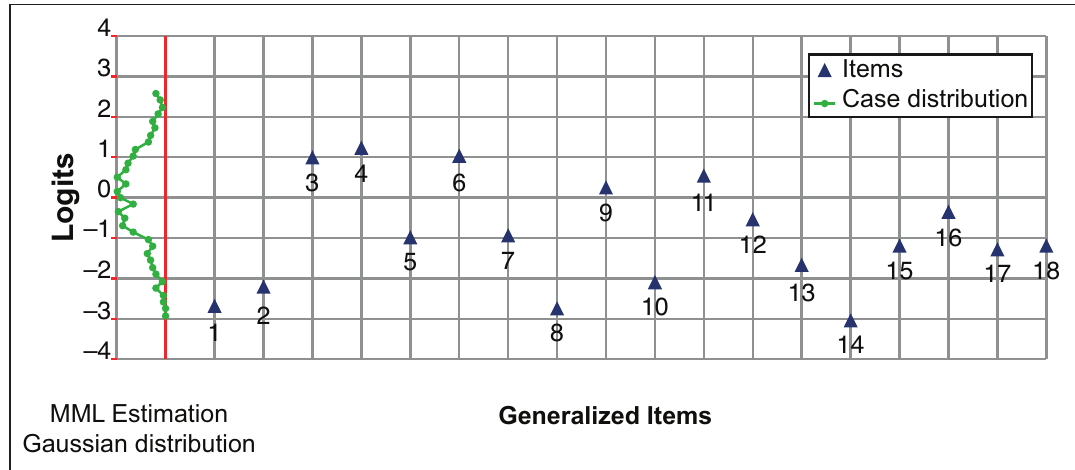
Figure 2 Wright map of N = 374 participants’ scientific reasoning (SR) abilities (marginal maximum likelihood [MML] estimation) and item difficulties (logits) for items 1–18 in the one-parameter logistic model (1PLM). Table 1 presents the item features for items 1–18 that were varied on